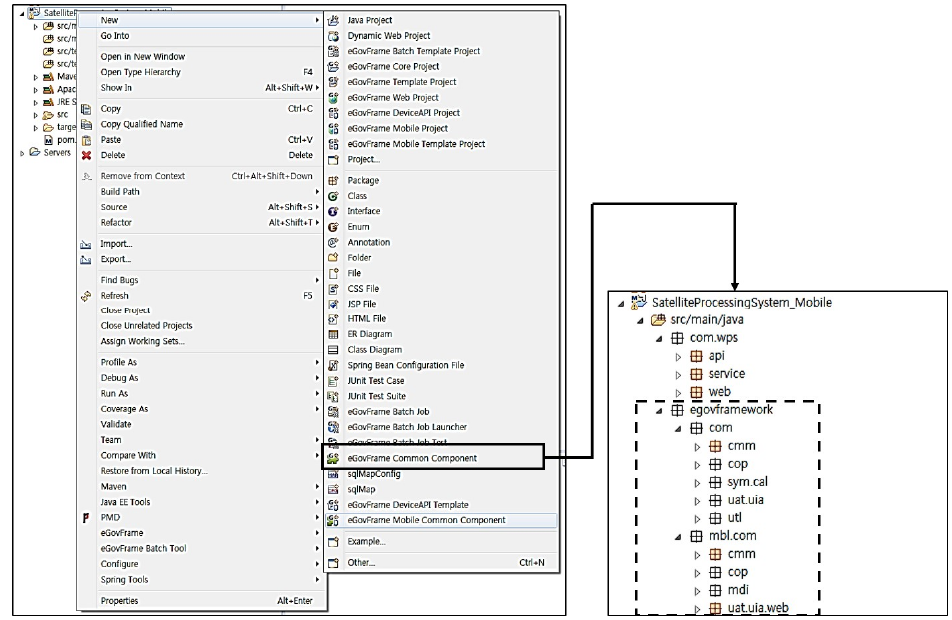
Figure 2. Application of common components for the eGovframework in South Korea. ISPRS Int. J. Geo-Inf. 2017 , 6 , 25